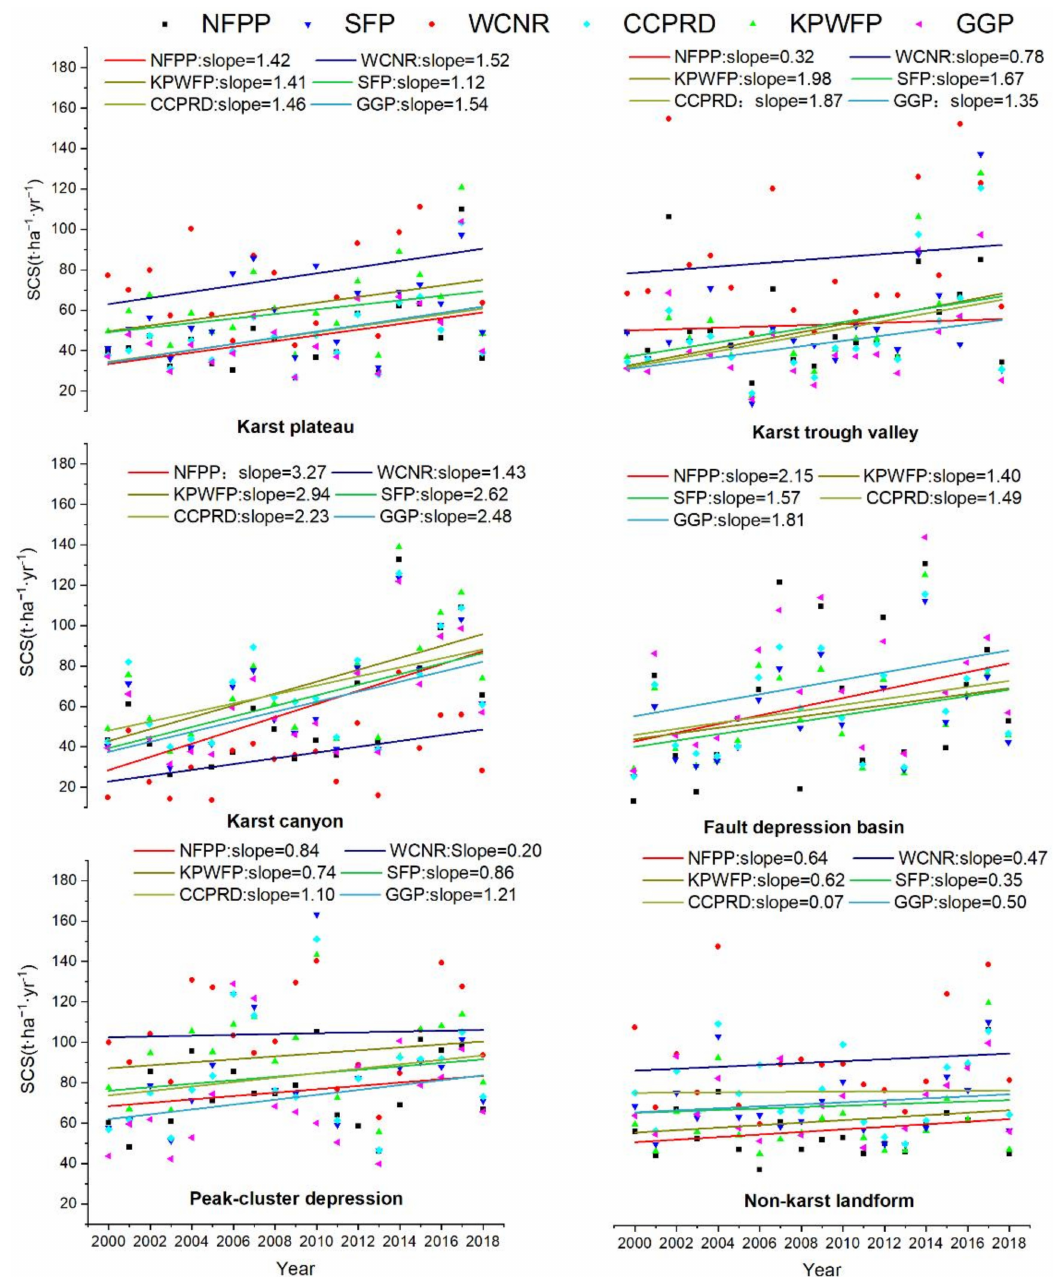
Figure 11. Interannual trend of temporal variation of SCS in di ff erent landform regions with di ff erent ecological engineering projects on the Guizhou